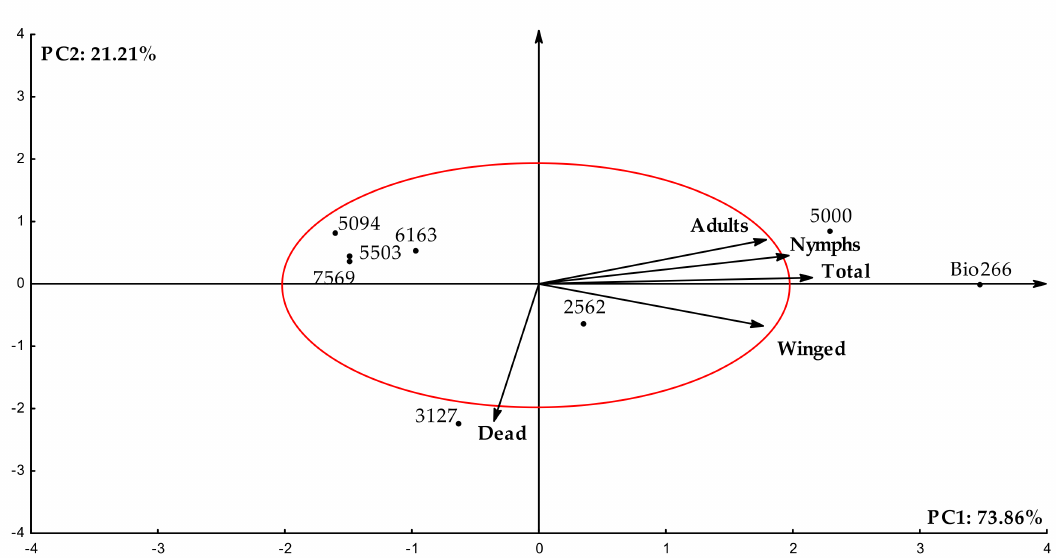
Figure 2. Biplot with dispersion of eight sugarcane cultivars regarding biological performance in the reproduction of wingless in-sects under no-choice conditions, analyzed seven days after release. Data submitted to exploratory multivariate principal component analysis